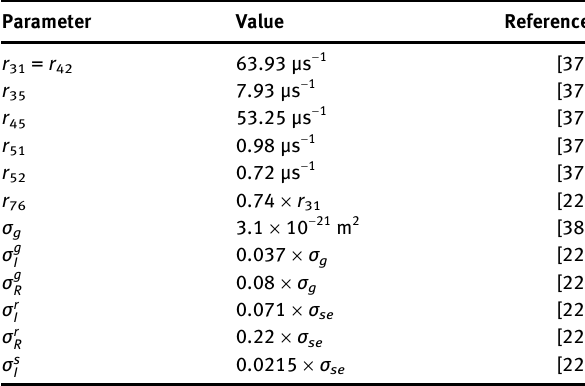
Table  : Parameters used for the theoretical estimations. The transition rates are the average of the values from the study by Tetienne et al. [  ]. σ g is the absorption cross sections of NV − for green wavelengths.